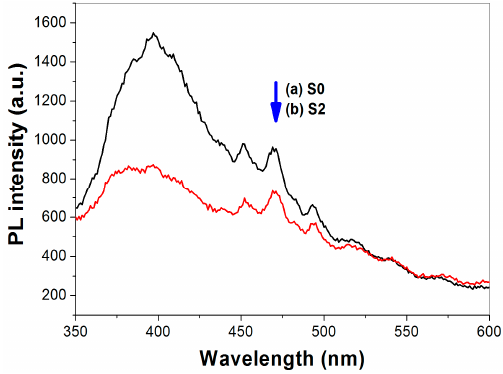
Figure 10. PL spectra of pristine R0 ( a ) and N-doped TiO 2 nanorods R2 ( b